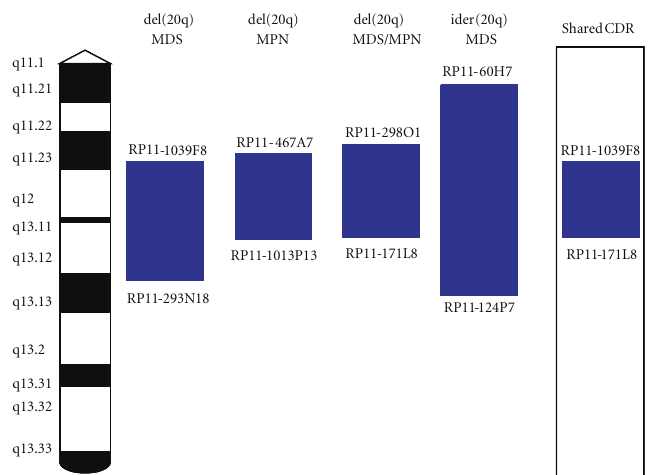
Figure 5: Ideogram of the long arm of chromosome 20. Delineation of commonly deleted regions (CDR). MDS: myelodysplastic syndrome; MPN: myeloproliferative